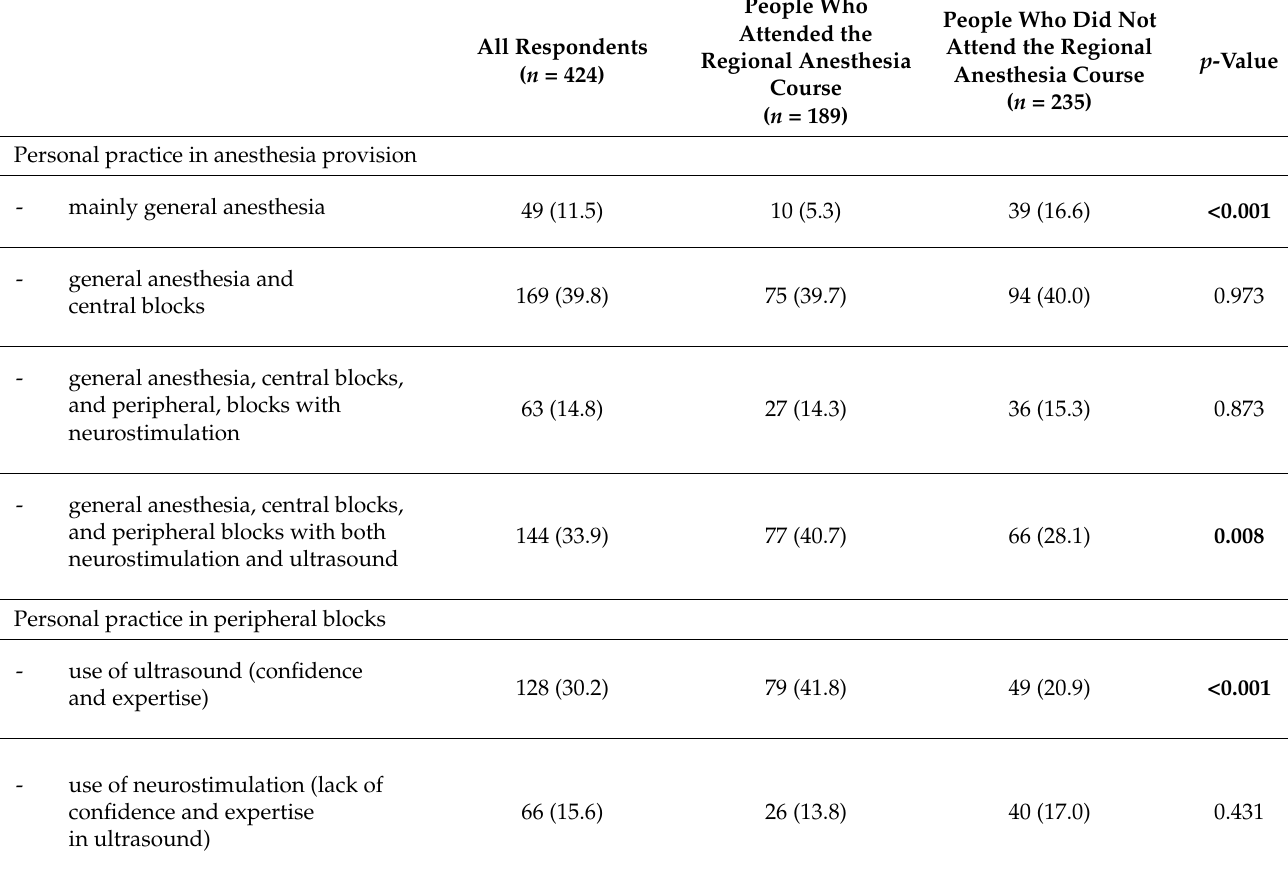
Table 1. Personal practice of respondents in aspects of regional anesthesia techniques; results are presented as number (percentage %); p value for the comparison between students who attended and did not attend the course; bold numerals denote a significant difference between people who attended the regional anesthesia course and those who did not ( p < 0.05). People Who People Who Did Attended the All Respondents Regional Anesthesia ( n = 424) ( n = 189)